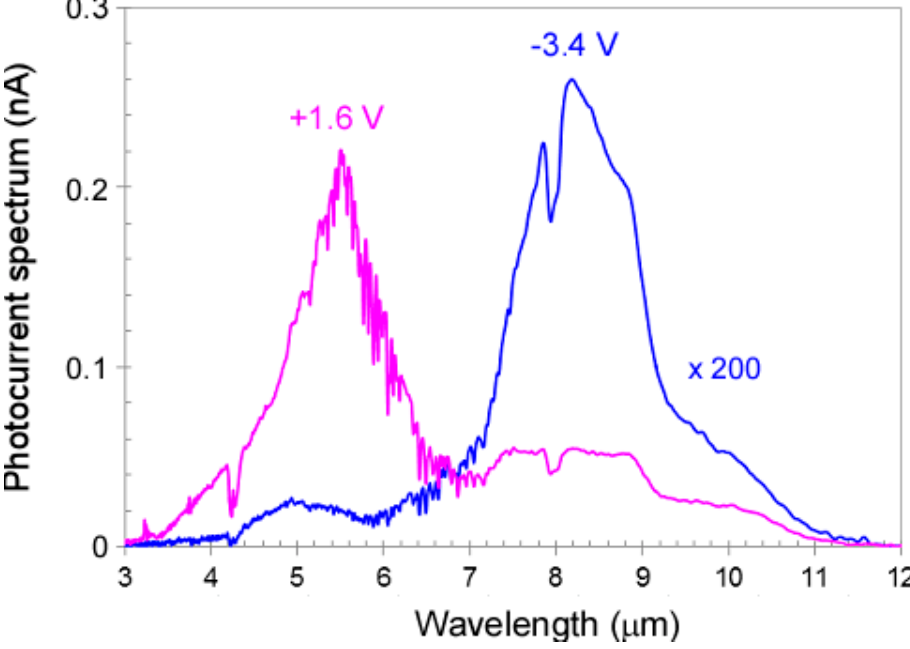
Figure 3. Photocurrent spectra of the dual-band QDIP under bias voltages of − 3.4 V (blue trace) and +1.6 V (pink trace). The negative bias gives the LWIR band, whereas under the positive bias, the MWIR band dominates.